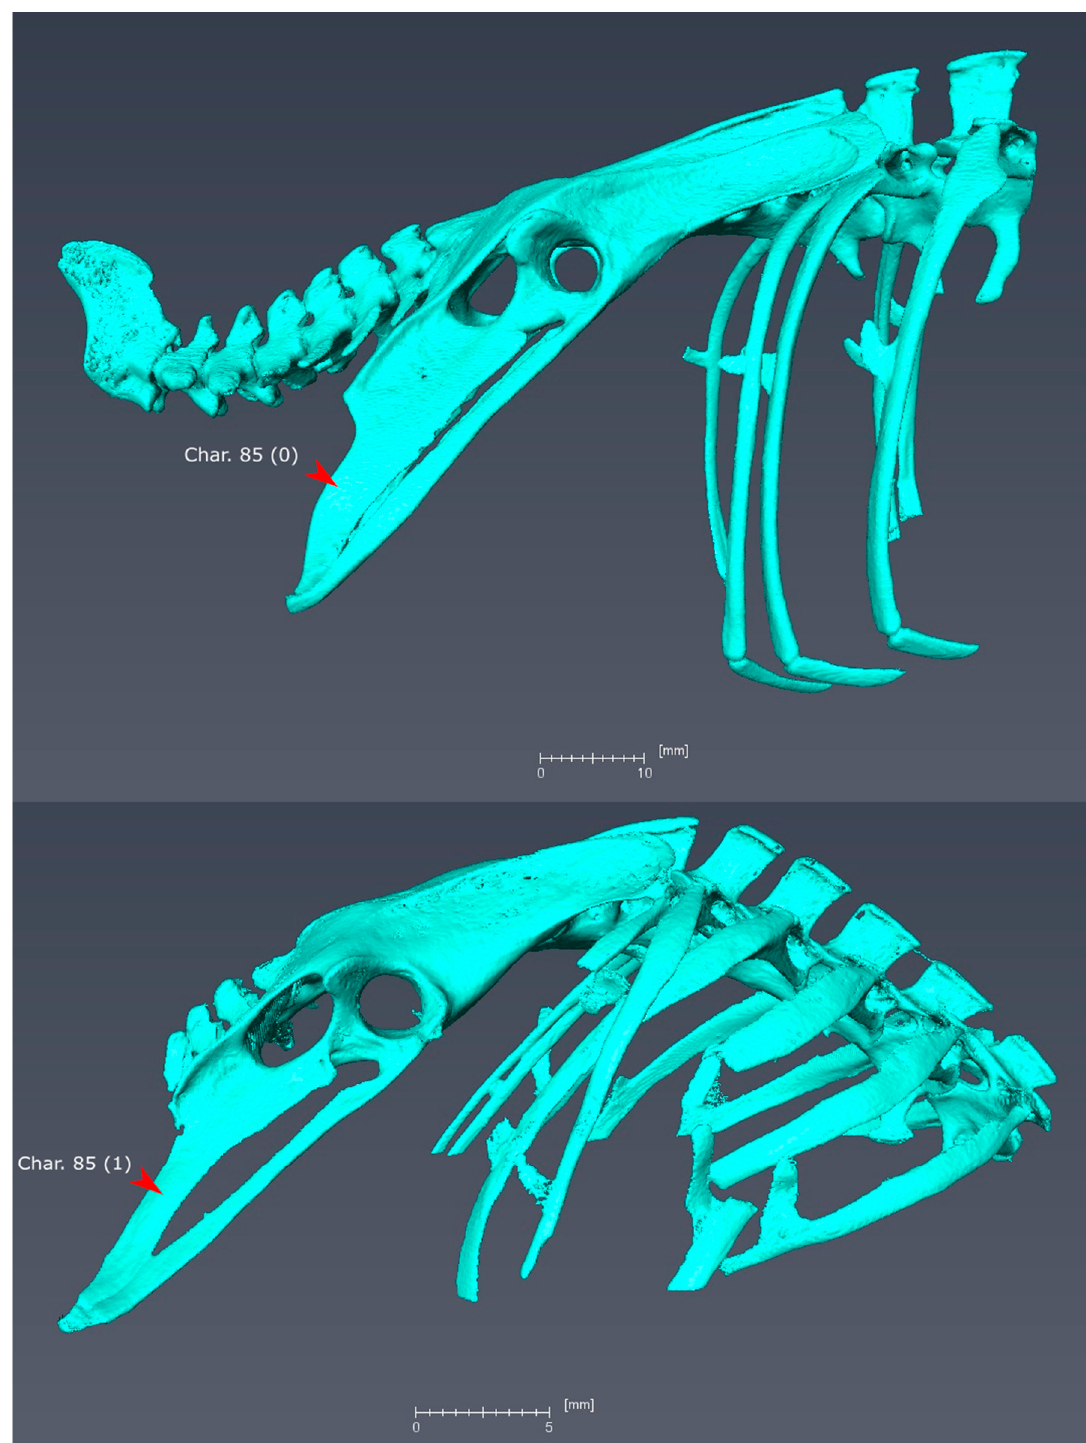
Figure A8. Pelvic girdles of Podargus strigoides (top) and Aegotheles cristatus (bottom) in right lateral view. Podargus exhibits state 0 for character 85 (terminal portion of ischium not slender), whereas Aegotheles exhibits state 1 (terminal portion of ischium slender, creating wide ischiopubic fenestra, optimized as a synapomorphy of Daedalornithes).